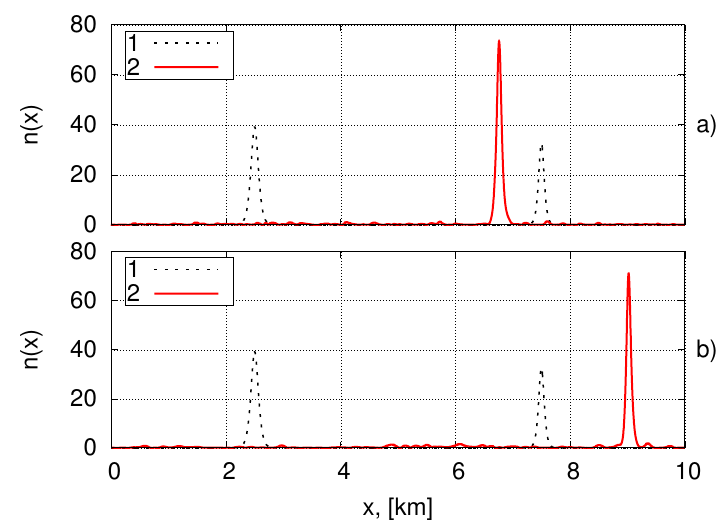
Figure 1. The number of particles densities n ( x ) for two different numerical experiments. Black dashed curves 1 in panels ( a ) and ( b ) correspond to initial states and red solid curves 2 in panels ( a ) and ( b ) to final